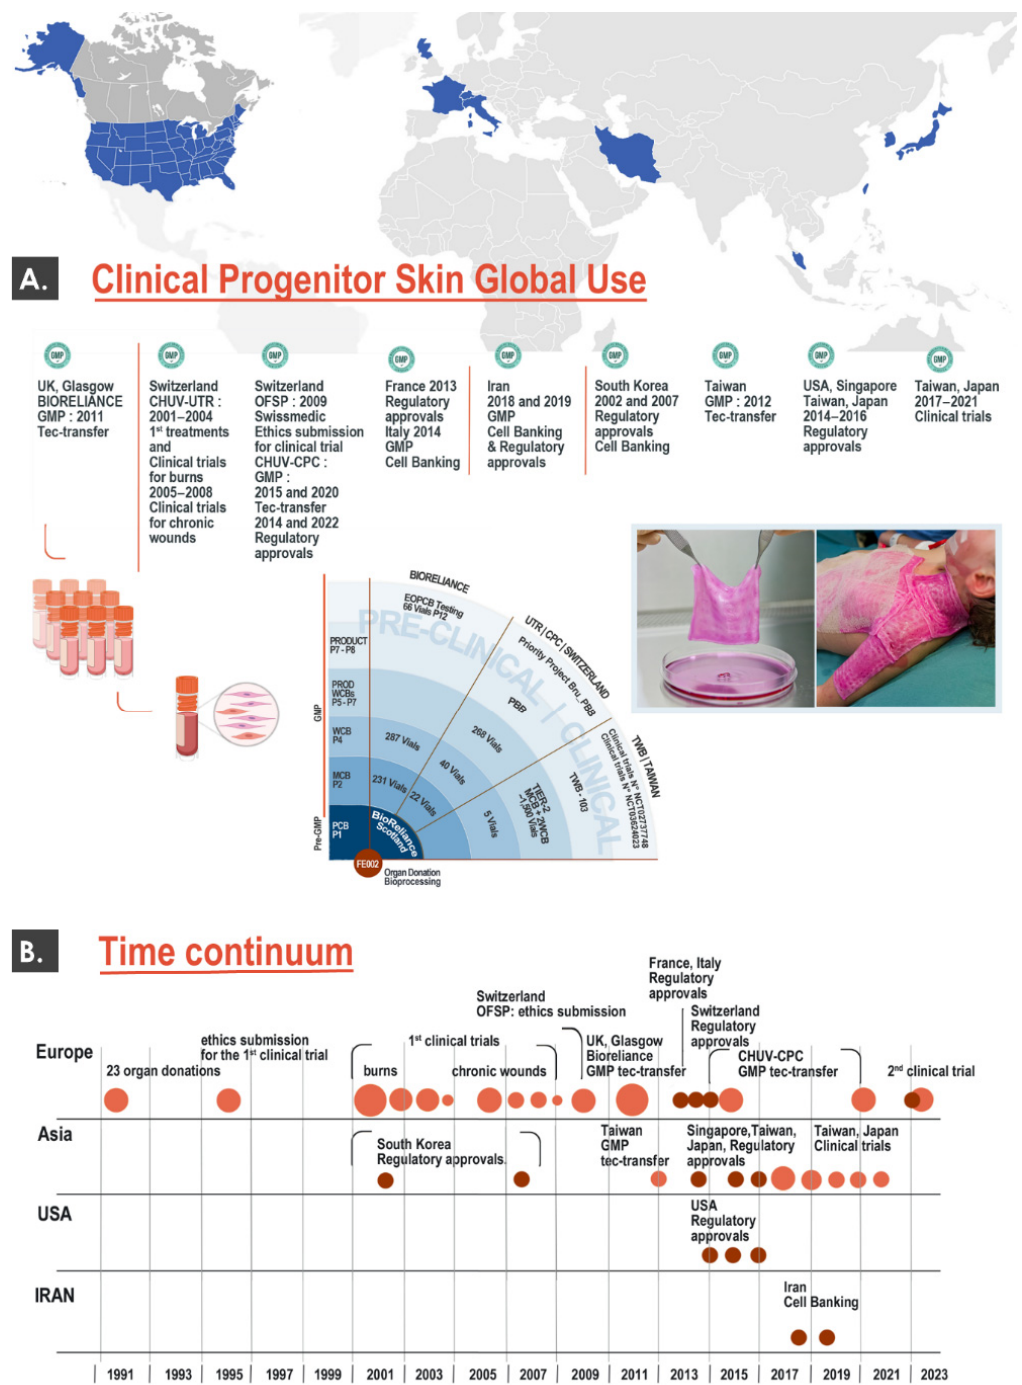
Figure 2. Overview of international developments in the clinical cytotherapeutic use of dermal progenitor cells. ( A ) The upper portion of the figure describes multiple steps of GMP cell banking and regulatory approvals for dermal progenitor cells, under the Swiss progenitor cell transplantation program and in alternative international clinical centers. ( B ) The lower portion of the figure describes major worldwide milestones over the past three decades for the eventual clinical use of dermal progenitor cells, covering the various international examples of clinical work described herein. It is important to note that all mentioned elements not referring to France, Italy, and Iran constitute activities carried out under the Swiss progenitor cell transplantation program. GMP, good manufacturing practices.